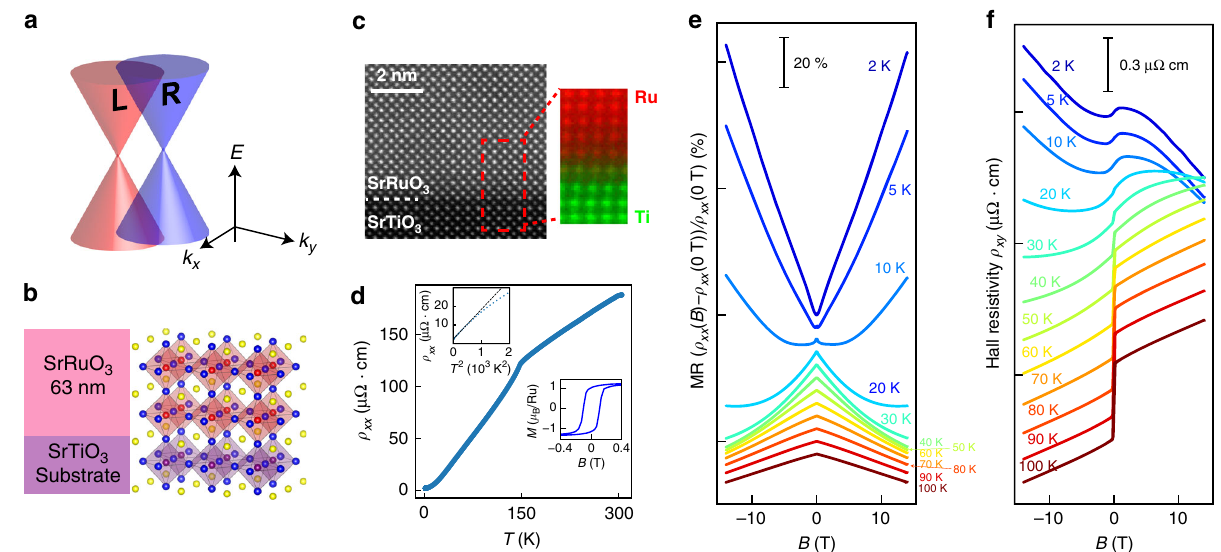
Fig. 1 Sample characteristics and temperature dependence of the magnetoresistance and Hall resistivity of SrRuO 3 . a Schematic image of a pair of Weyl nodes with opposite chiralities (L and R). In ferromagnetic SrRuO 3 , the TRS breaking lifts the spin degeneracy and leads to linear band crossing at many k points, resulting in a pair of Weyl nodes with opposite chiralities. b Schematic of the sample and crystal structures of the SrRuO 3 fi lms (63-nm thick) on a SrTiO 3 substrate. In the schematic crystal image, yellow, blue, red, and purple spheres indicate strontium, oxygen, ruthenium, and titanium, respectively. c Cross-sectional high-angle annular dark fi eld scanning transmission electron microscopy (HAADF-STEM) image of the SrRuO 3 fi lm with the RRR of 71 taken along the [100] axis of the SrTiO 3 substrate. The inset in c shows a color overlay of the electron energy loss spectroscopy (EELS)-STEM images for the Ti- L 2,3 - (green) and Ru- M 4,5 -edge (red). Epitaxial growth of the high-quality single-crystalline SrRuO 3 fi lm with an abrupt substrate/ fi lm interface is seen in the images. d ρ xx – T curves for the SrRuO 3 fi lm with the RRR of 84.3. The left inset in d shows the ρ xx vs. T 2 plot with the linear fi tting (black dashed line). We de fi ned the Fermi liquid region as the temperature range where the experimental ρ xx and the fi tting line are close enough to each other (<0.1 μΩ cm). The right inset in d shows the magnetization M vs. B curve at 10 K with B applied in the out-of-plane [001] direction of the SrTiO 3 substrate. e , f MR ( ρ xx ( B ) − ρ xx ( 0 T))/ ρ xx (0 T) and Hall resistivity ρ xy ( B ) curves at 2 – 100 K for the SrRuO 3 fi lm with the RRR of 84.3 with B applied in the out-of-plane [001] direction of the SrTiO 3 substrate. In e and f , the MR and the Hall resistivity at each temperature have been offset by 7% and 0.22 μΩ cm, respectively, for easy